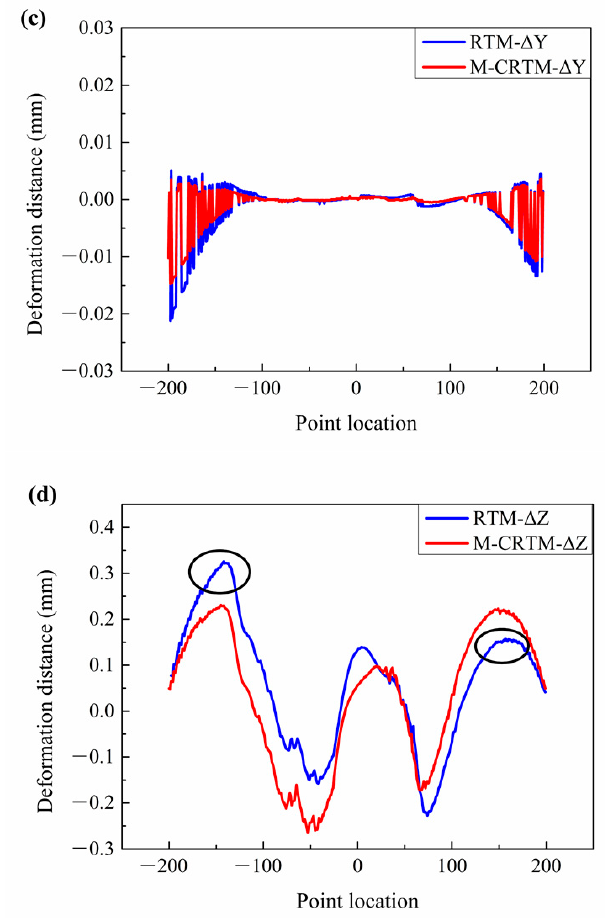
Figure 12. Deformation distance analysis of Section 3. ( a ) The overall deformation distance of Section 3; ( b ) deformation distance of Section 3 in X direction; ( c ) deformation distance of Section 3 in Y direction; ( d ) deformation distance of Section 3 in Z direction.